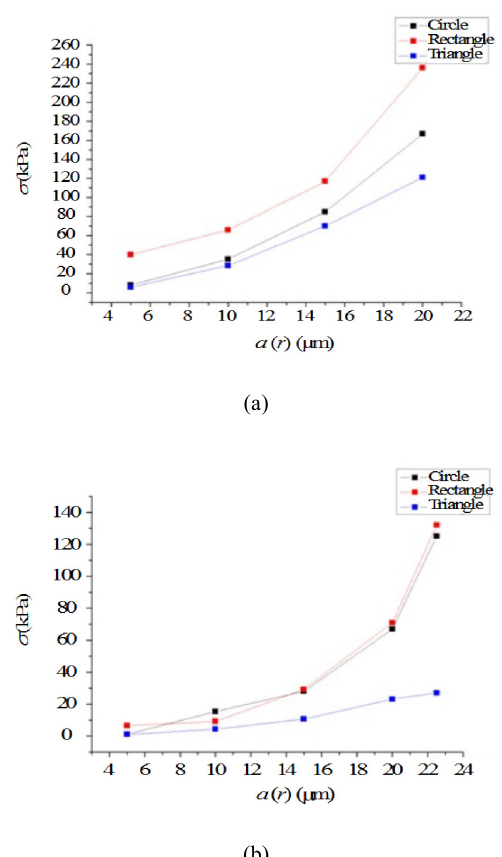
Fig. 11 Changes in the strain differences of these three kinds of side-hole fibers: (a) strain differences versus holes size a ( r ) of three kinds of side-hole fibers at the pressure of 1 × 10 5 Pa on the fiber surface and (b) strain differences versus with holes size a ( r ) of three kinds of side-hole fibers at the temperature of 80 ℃